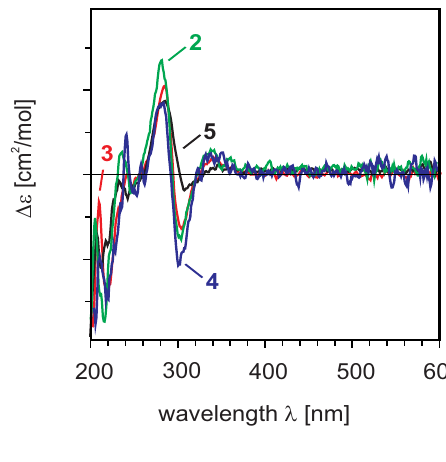
Figure 4. Experimental CD spectra of compounds 2–5 .